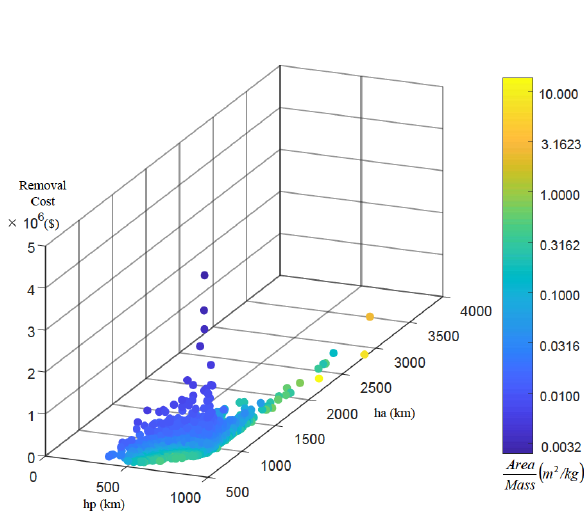
Figure 13. Method of selecting the interception point